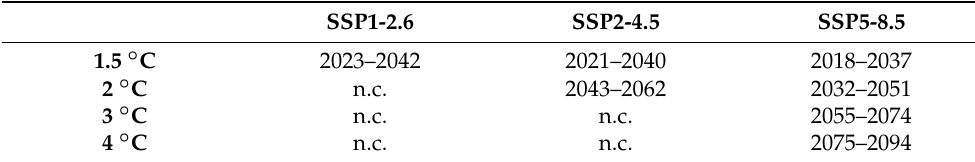
Table 1. The years corresponding to the different target temperature rise scenarios defined by the IPCC report. The n.c. means that the level was not crossed during the period of